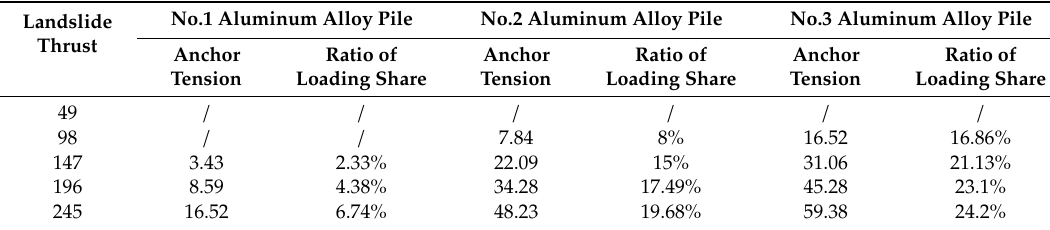
Table 2. Anchor tension and the ratio of loading share in epoxy resin pile model (Unit: N). Landslide Thrust